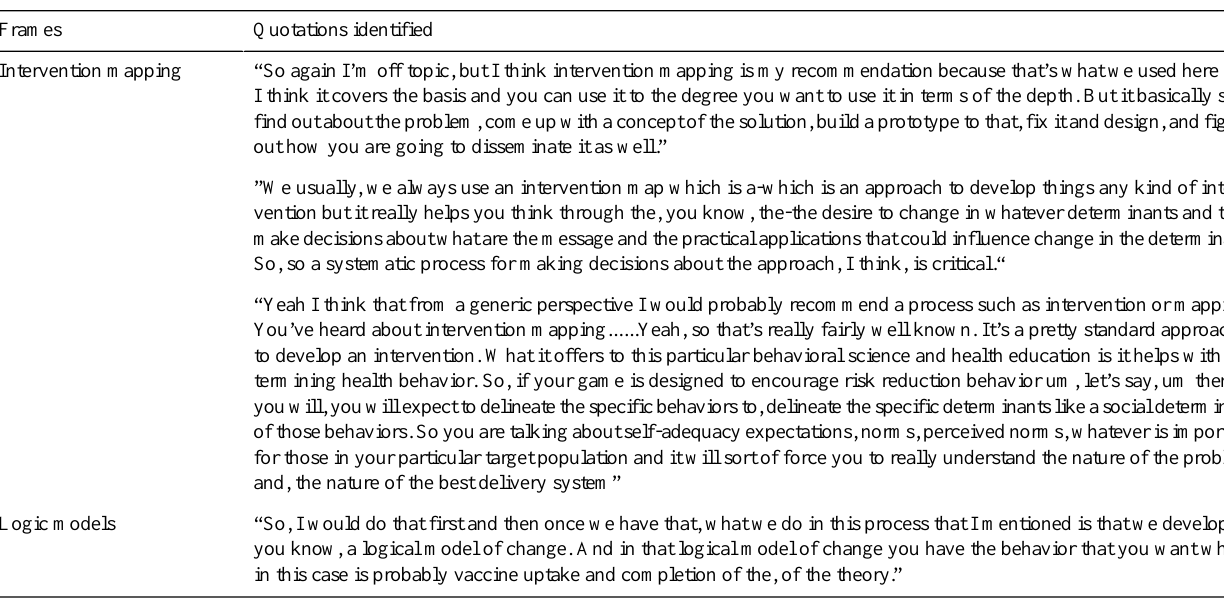
Table 2. Program planning models